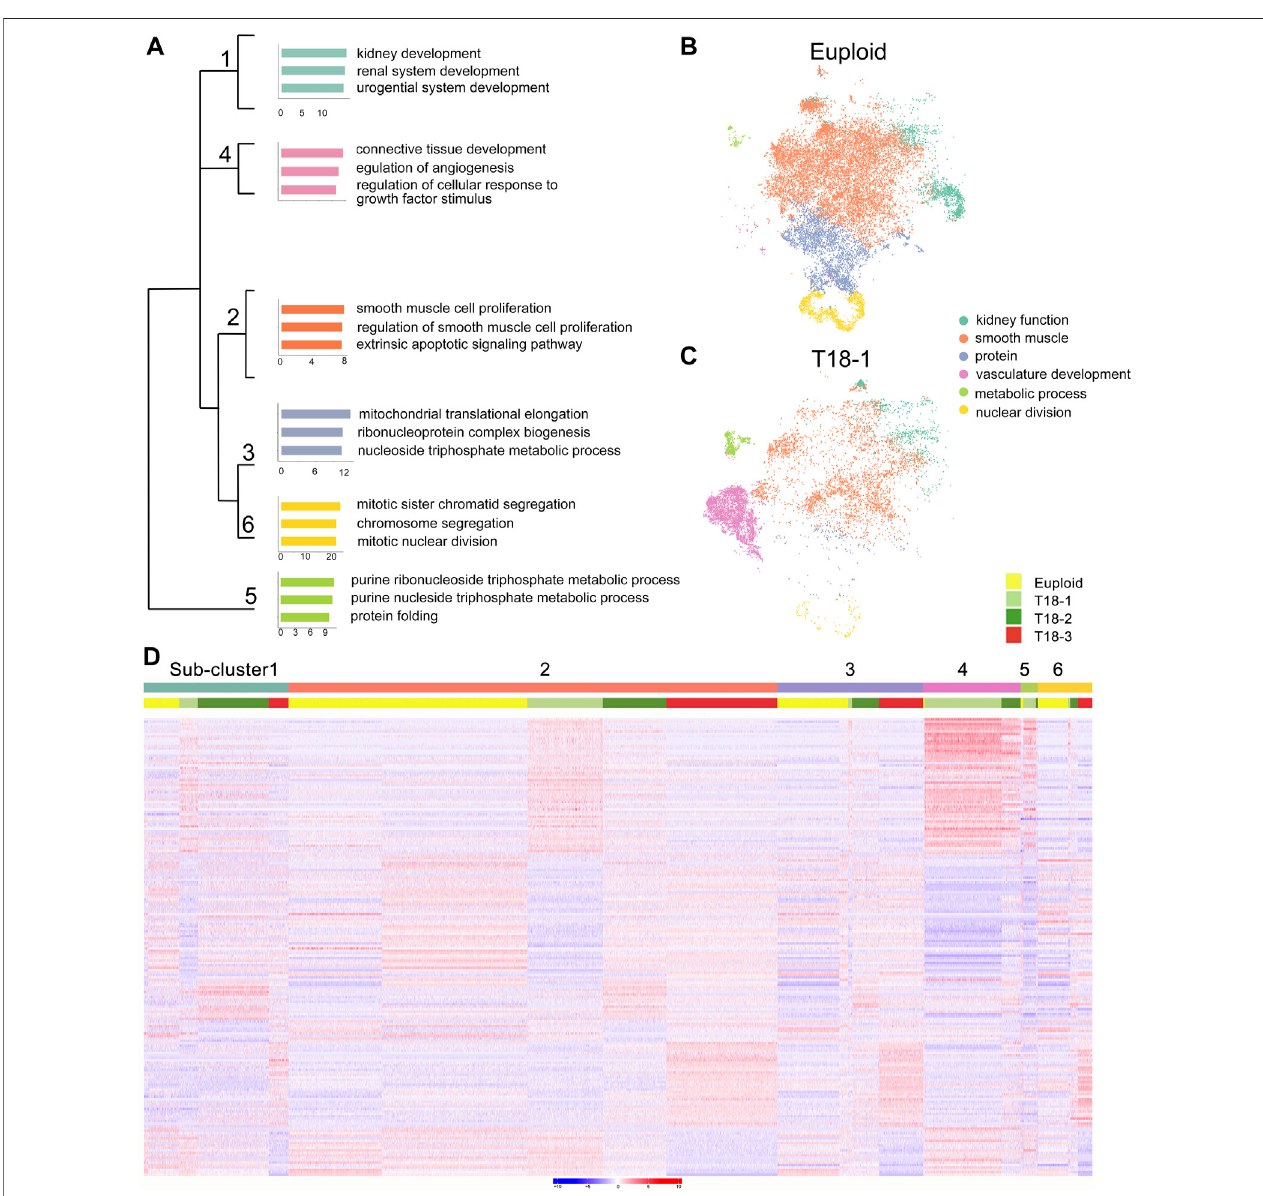
FIGURE1| Functionalgroupingofamniotic fl uidcellsfromeuploidandtrisomy18(T18)samples. (A) Differentfunctionalsub-clusterswereannotatedaccordingto expression of signi fi cantly altered genes for two euploid samples. Gene ontology (GO) analyses of differentially expressed genes in three trisomy 18 samples were compared with two euploid samples. (B,C) t-distributed Stochastic Neighbor Embedding (t-SNE) projection of cells and typical gene expression in euploid and T18-1 cells. (D) Heatmap of differentially expressed genes in two euploid and three trisomy 18 samples.